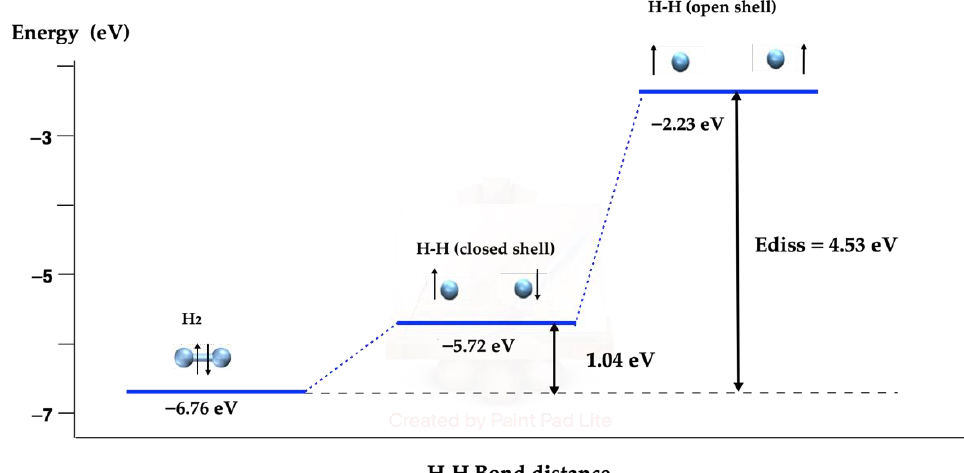
Figure 1. H 2 dissociation pathway in vacuum. The blue spheres represent H atoms.